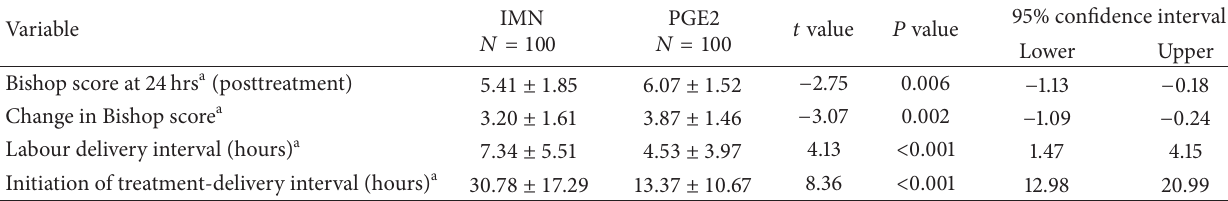
Table 3: Comparison of labour and delivery characteristics.